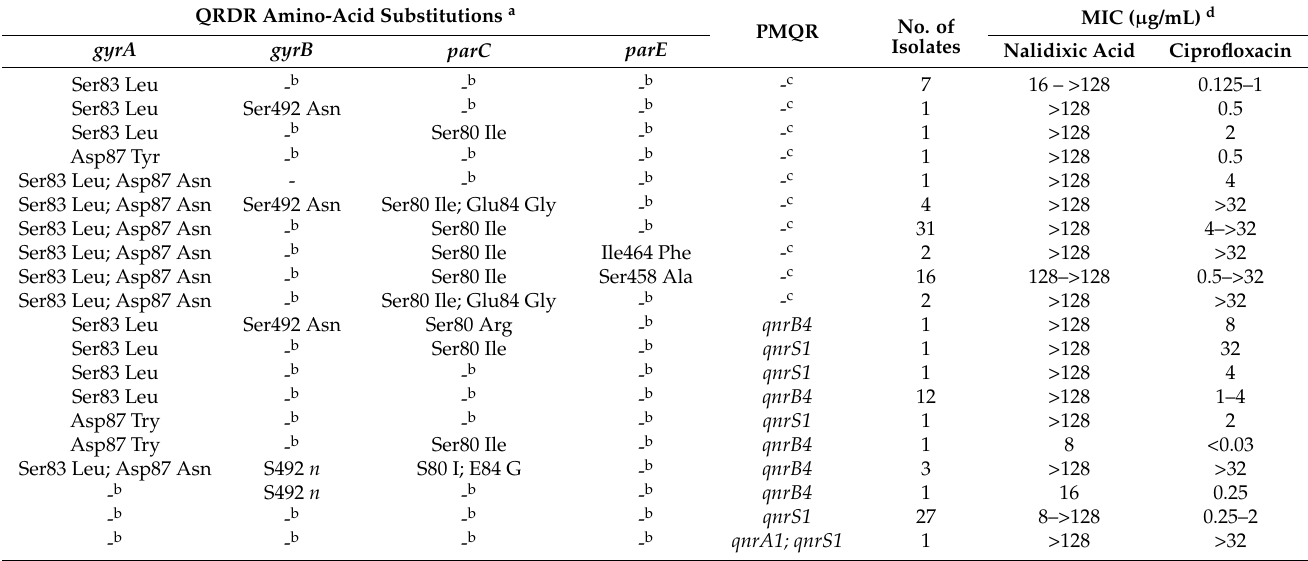
a QRDR substitutions: gyrA —Ser83 Leu: serine to leucine at codon 83; Asp87 Asn: aspartic acid to asparagine/tyrosine at codon 87; gyrB —Ser492 Asn: serine to aspartic acid at codon 492; parC —Ser80 Ile/Arg: serine to isoleucine/arginine at codon 80; Glu84 Gly: glutamic acid to glycine at codon 84; parE —Ser458 Ala: serine to alanine at codon 458; Ile464 Phe: isoleucine to phenylalanine at codon 464. b No